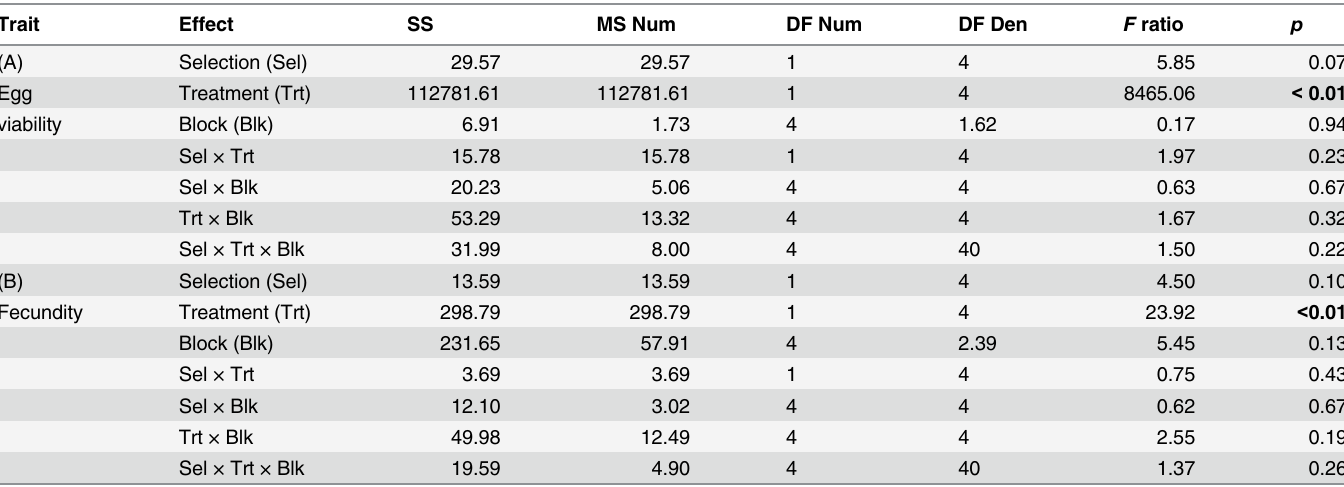
Table 6. Egg viability and fecundity post cold shock (Experiment 3).